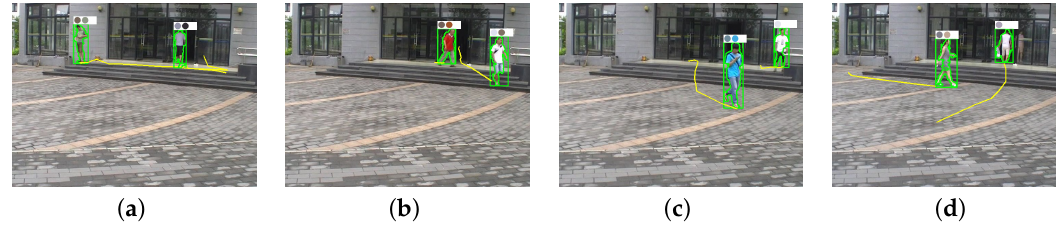
Figure 21. Results of the proposed algorithm using a public dataset [26]: ( a – d ) four frames in the test video with re-identified